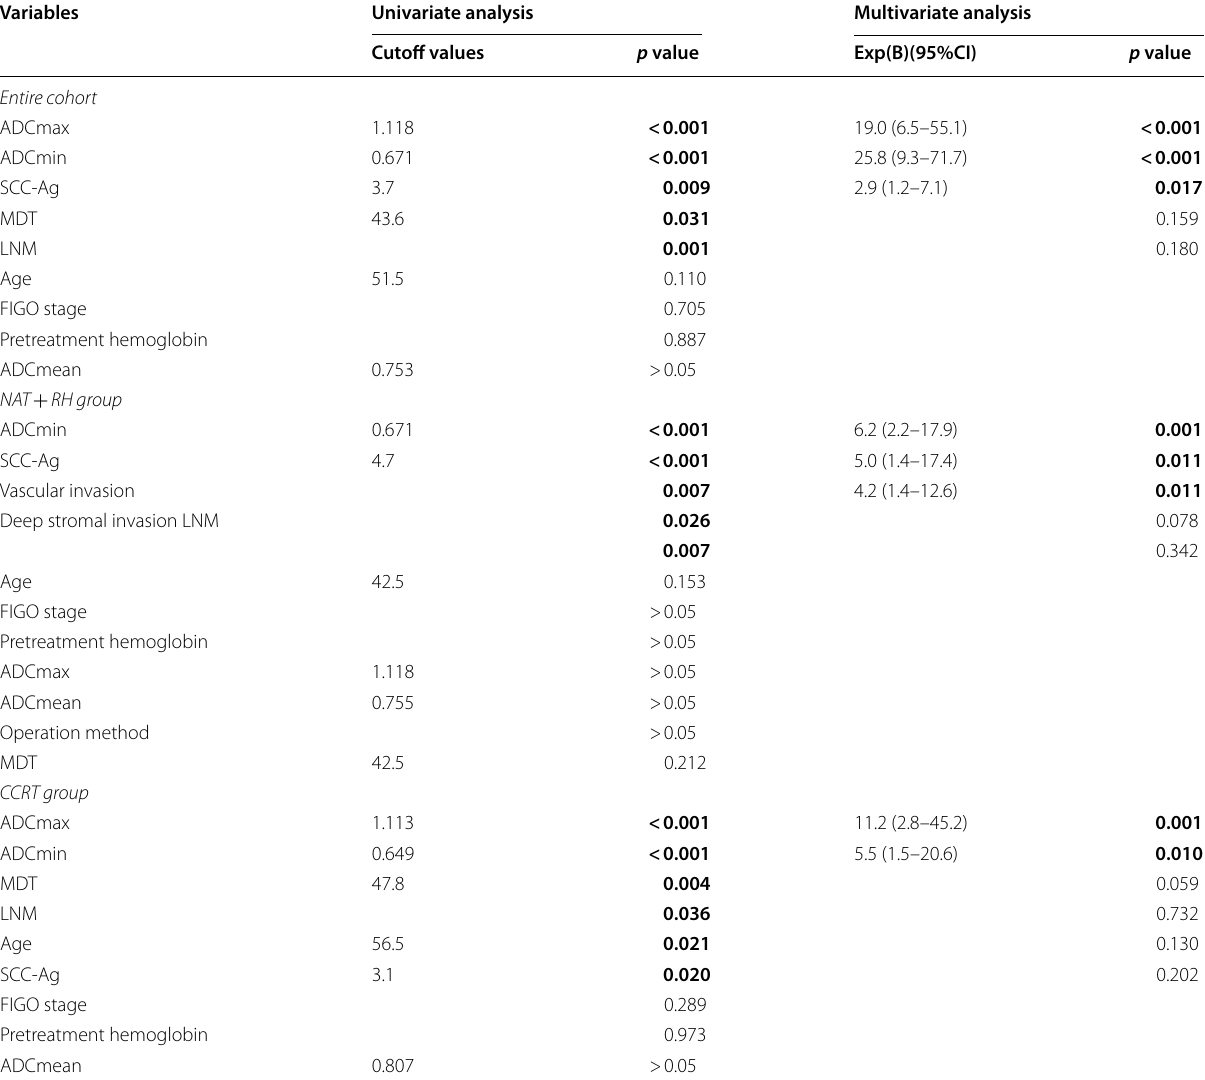
Table 5 Univariate and multivariate analysis of clinical and imaging factors for evaluating disease-free survival